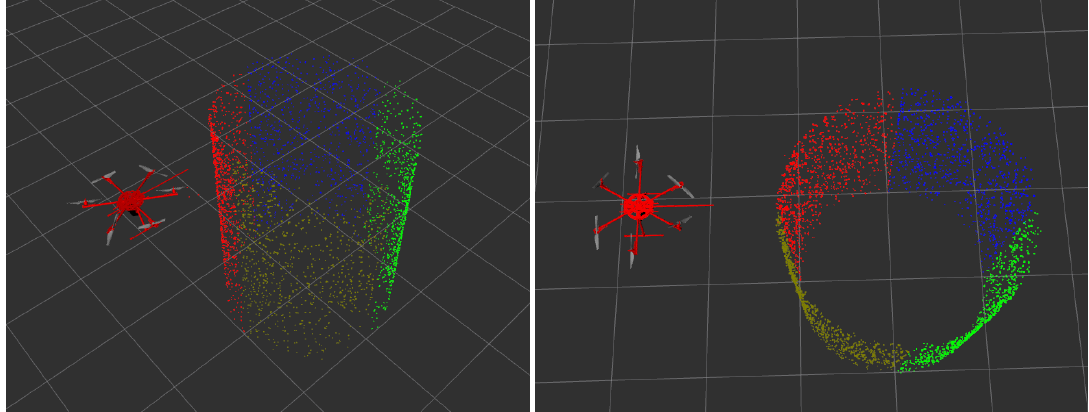
Figure 4. Side and top view of detected points. Point cloud is false colored in order to show the different segments. (Segment 0 = red points, Segment 1 = blue points, Segment 2 = green points, Segment 3 = yellow